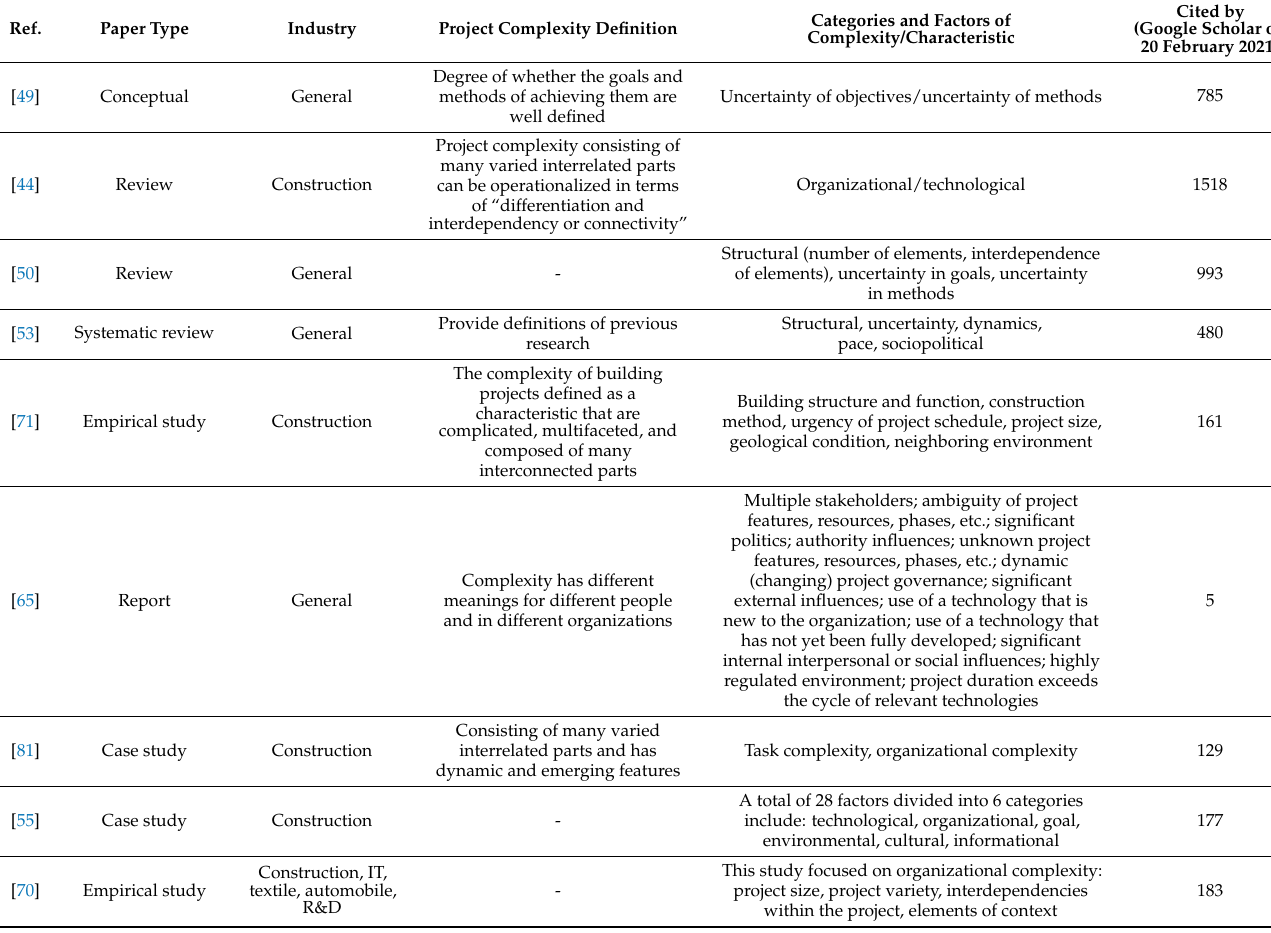
Table 3. Overview of the selected papers of literature focused on project